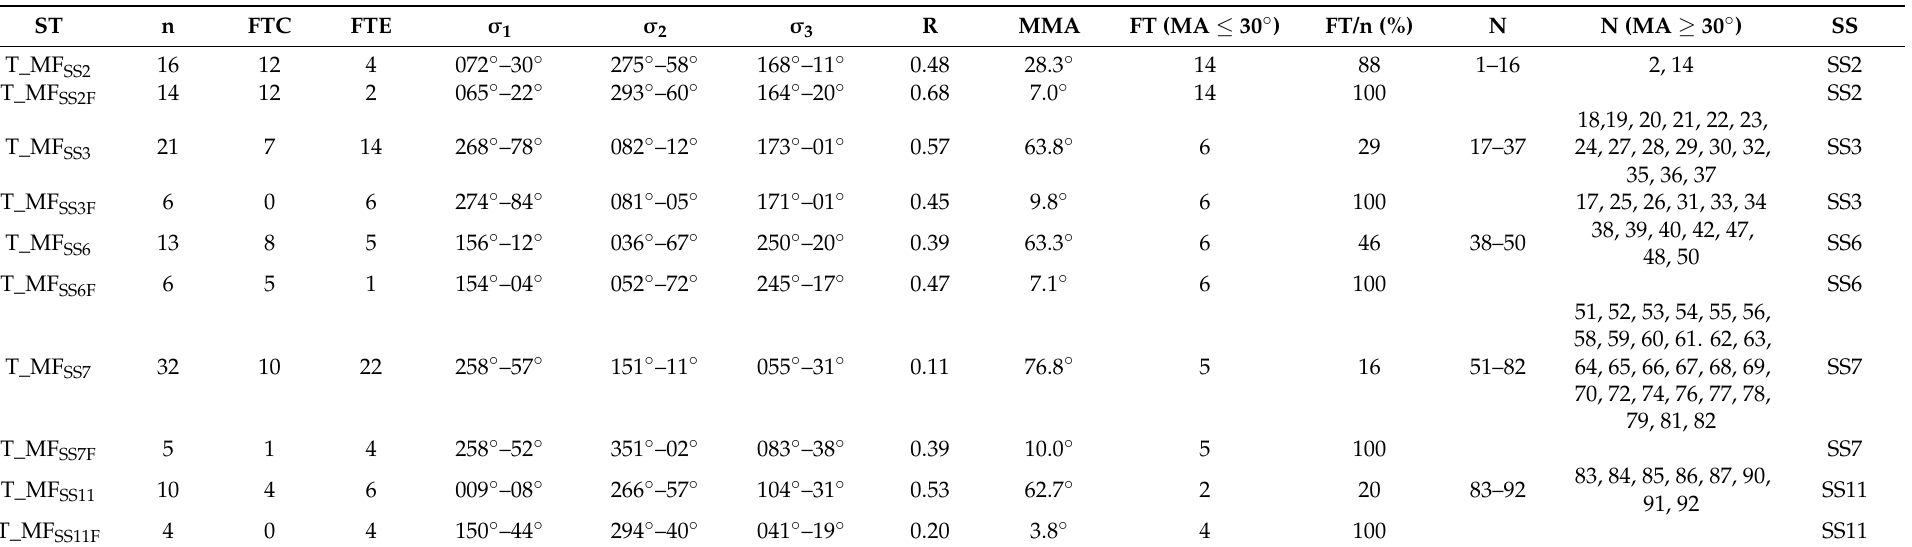
Table 1. Best-fit stress tensors with MyFault, software, and MA ≤ 30 ◦ .